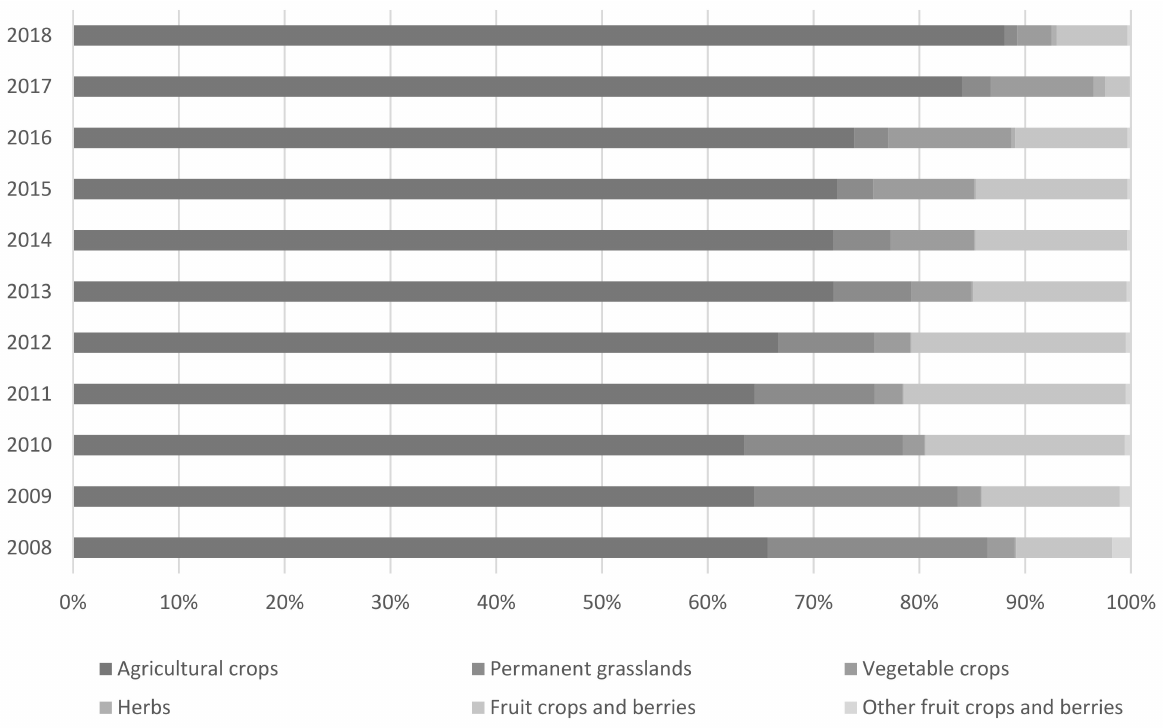
Figure 3. Payment amounts by organic farming option in the 2007–2013 RDP. Source: own compilation based on